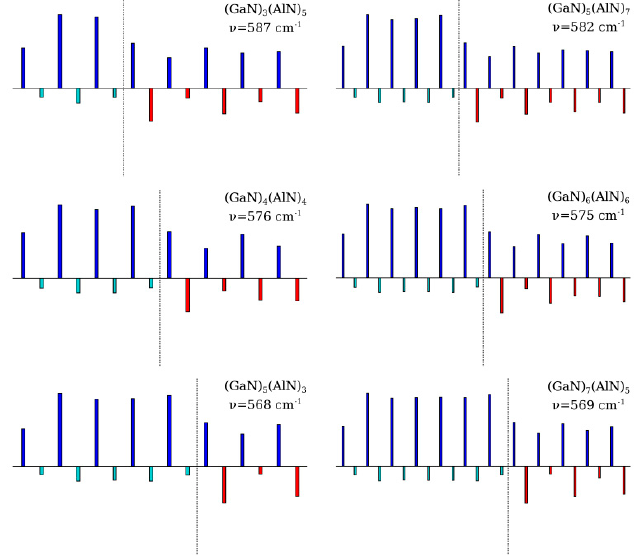
Figure 9. Calculated atomic z -displacement amplitudes for the delocalized A 1 (TO) modes of the (GaN) m /(AlN) n SLs: blue, cyan, and red bars correspond to displacements of N, Ga, and Al atoms, respectively.